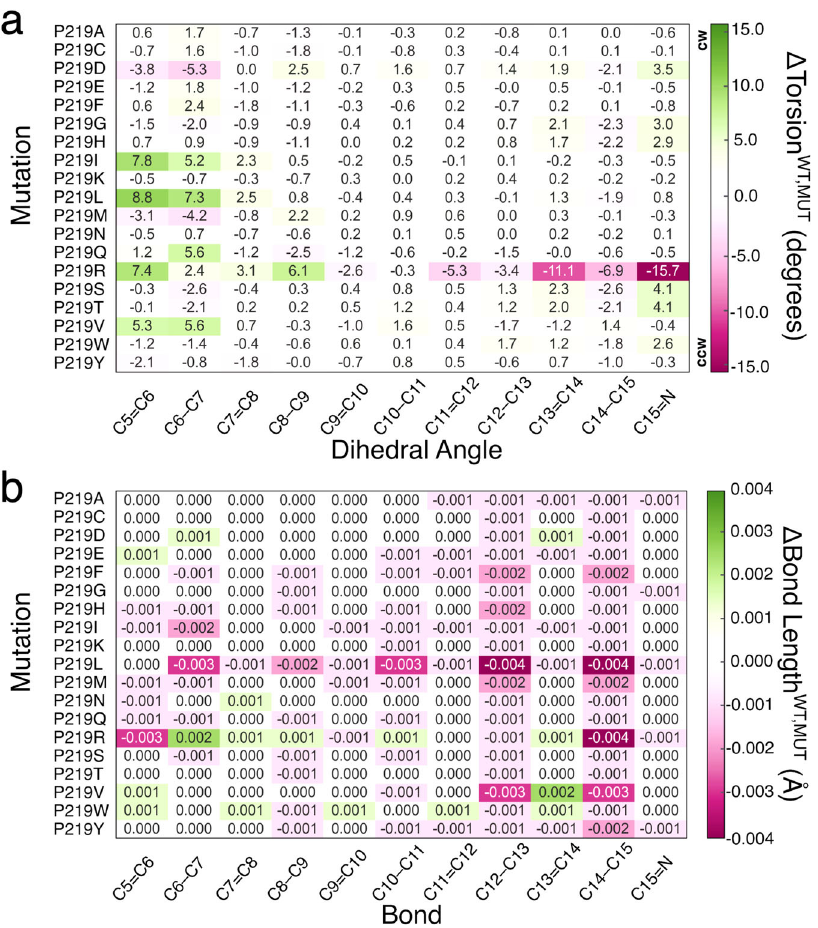
Fig. 7 Heatmap representation of the variation of structural parameters of P219X (X = A, C, D, E, F, G, H, I, K, L, M, N, Q, R, S, T, V, W, Y) mutants with respect to the wild-type KR2 (WT-KR2). Difference between WT-KR2 and mutant ( a ) dihedral angles, Δ Torsion WT ; MUT and ( b ) bond lengths, Δ BondLength WT ; MUT . Counterclockwise (CCW) and clockwise (CW) orientation of the